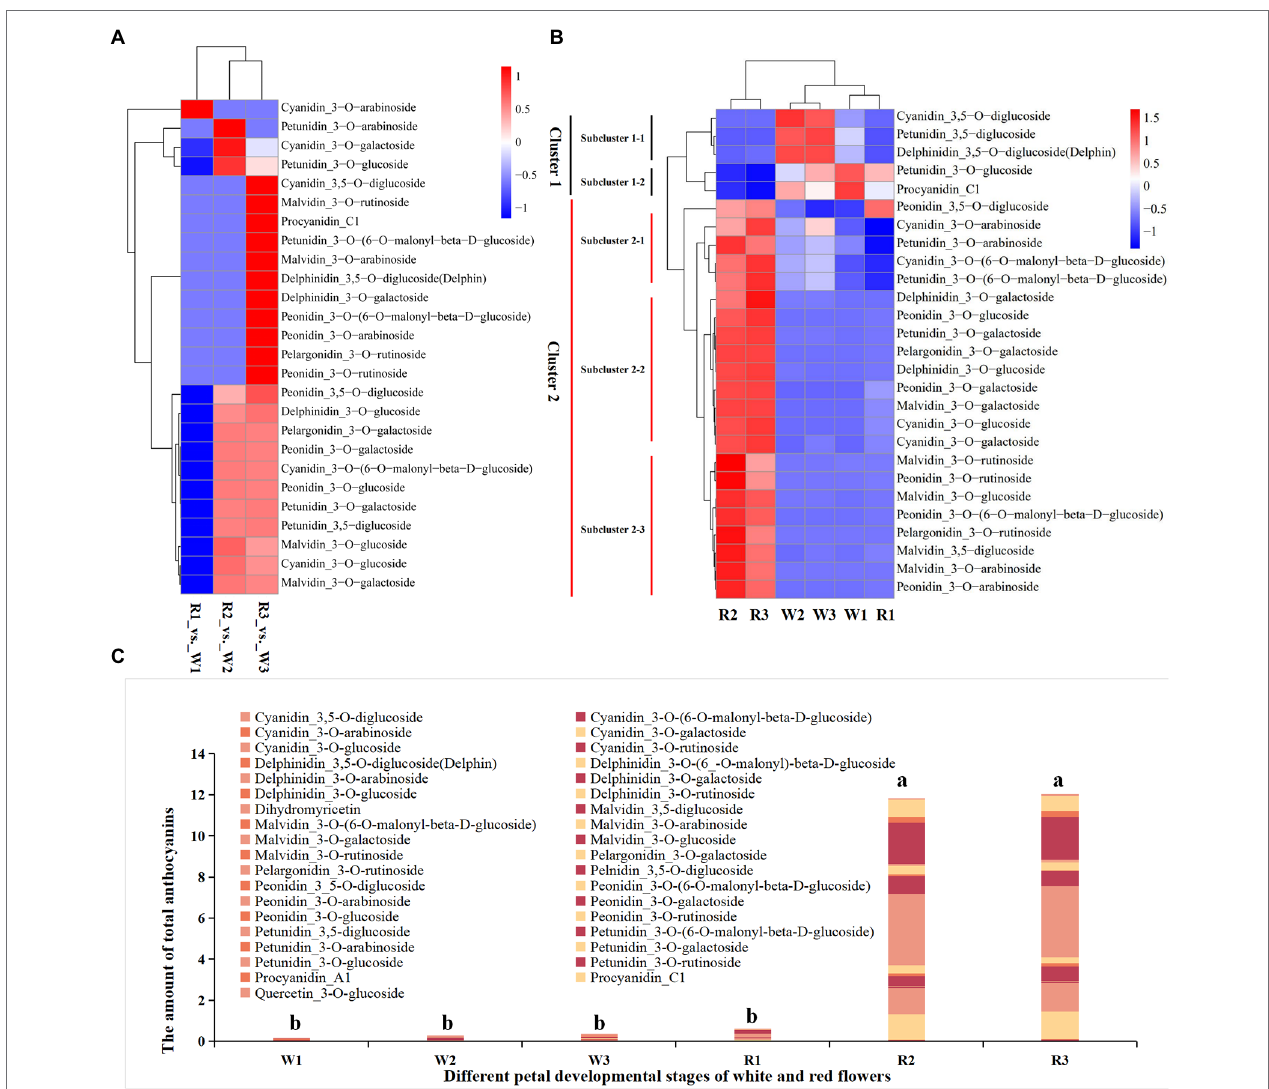
FIGURE 2 | Heatmap of metabolites in the early (W1, R1), middle (W2, R2), and blooming stages (W3, R3) in white (W) and red (R) flowers. (A) Heatmap of differentially accumulated metabolites at different stages and fold changes. (B) Heatmap of differentially accumulated metabolites at different stages. The amounts of metabolites detected by an absolute quantitative method were used for heatmap clustering. (C) Total amount of anthocyanins at different stages of the two lines. a and b indicate significant difference ( p <